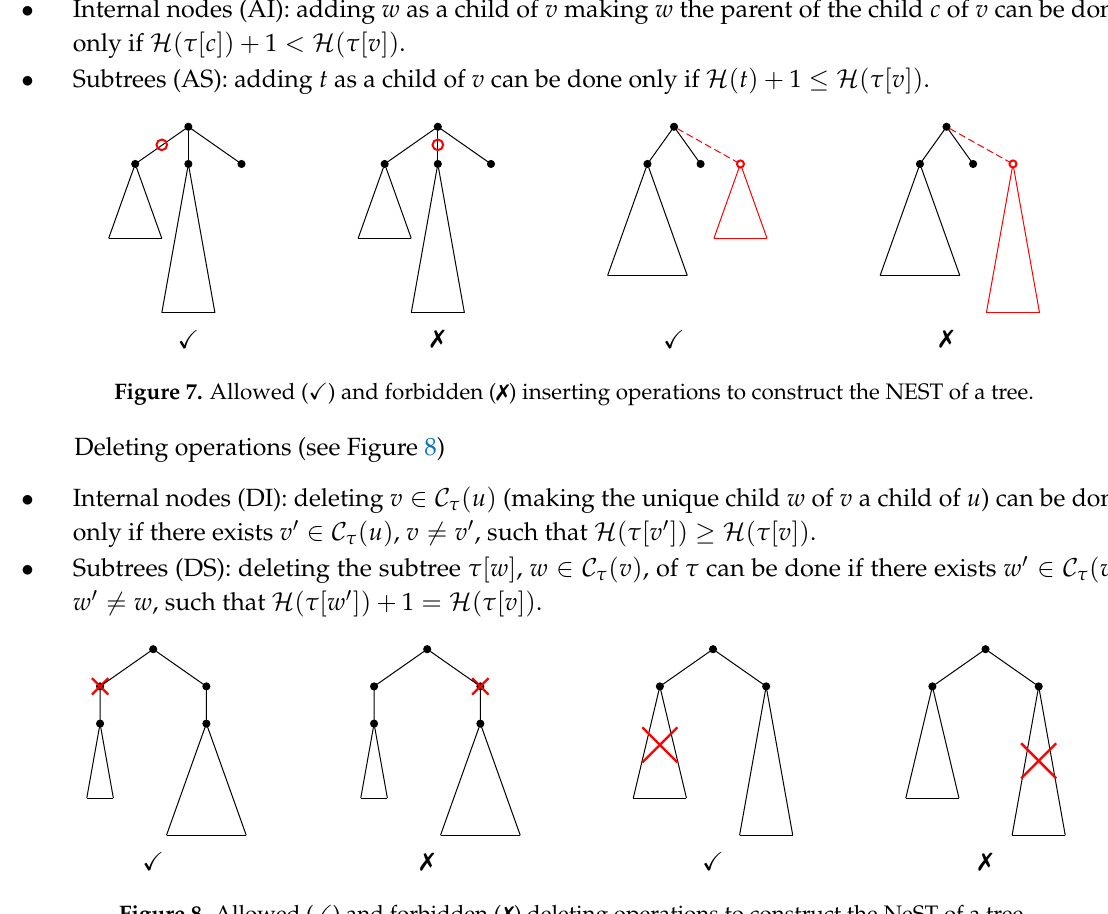
Figure 8. Allowed ( (cid:88) ) and forbidden ( (cid:55) ) deleting operations to construct the NeST of a